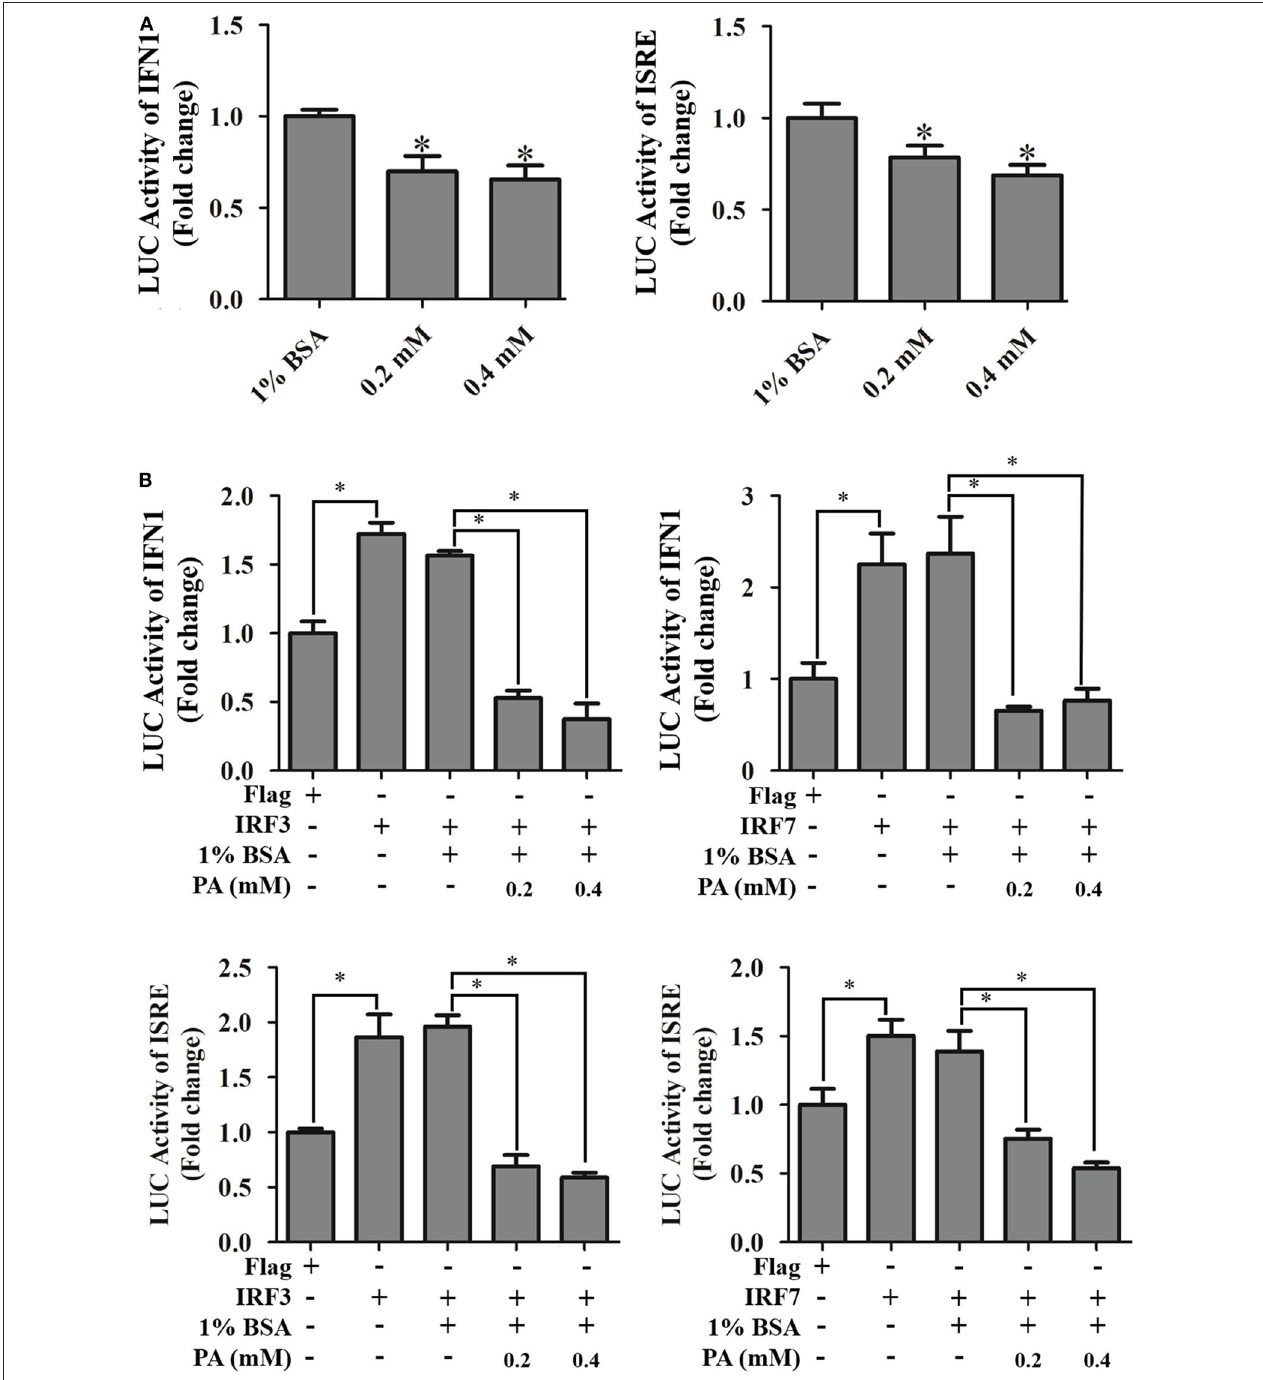
FIGURE 7 | Effects of palmitic acid on IFN1 promoter, and ISRE promoter activity. (A) Treatment of palmitic acid decreased promoter activities of IFN1 and ISRE. GS cells were co-transfected with IFN1-Luc/ISRE-Luc and pRL-SV40 Renilla luciferase vector, and treated with 1% BSA or indicated concentration of palmitic acid (0.2 or 0.4mM), respectively. The promoter activity was measured using the luciferase reporter gene assay. Setting promoter activity in 1% BSA treated group as 1-fold. (B) Palmitic acid reduced IRF3/7 evoked IFN1 and ISRE activity. After transfection, GS cells were incubated with 1% BSA or 0.2mM, 0.4mM palmitic acid. Luciferase vs. Renilla luciferase activities in cell lysates was measured and expressed as the fold stimulation. Setting promoter activity in Flag transfected group as 1-fold. All data are representative of three independent experiments. The data are represented as mean ± SD, and the statistical significances were determined with Student’s t -test, n = 3. The significance level was defined as * p <